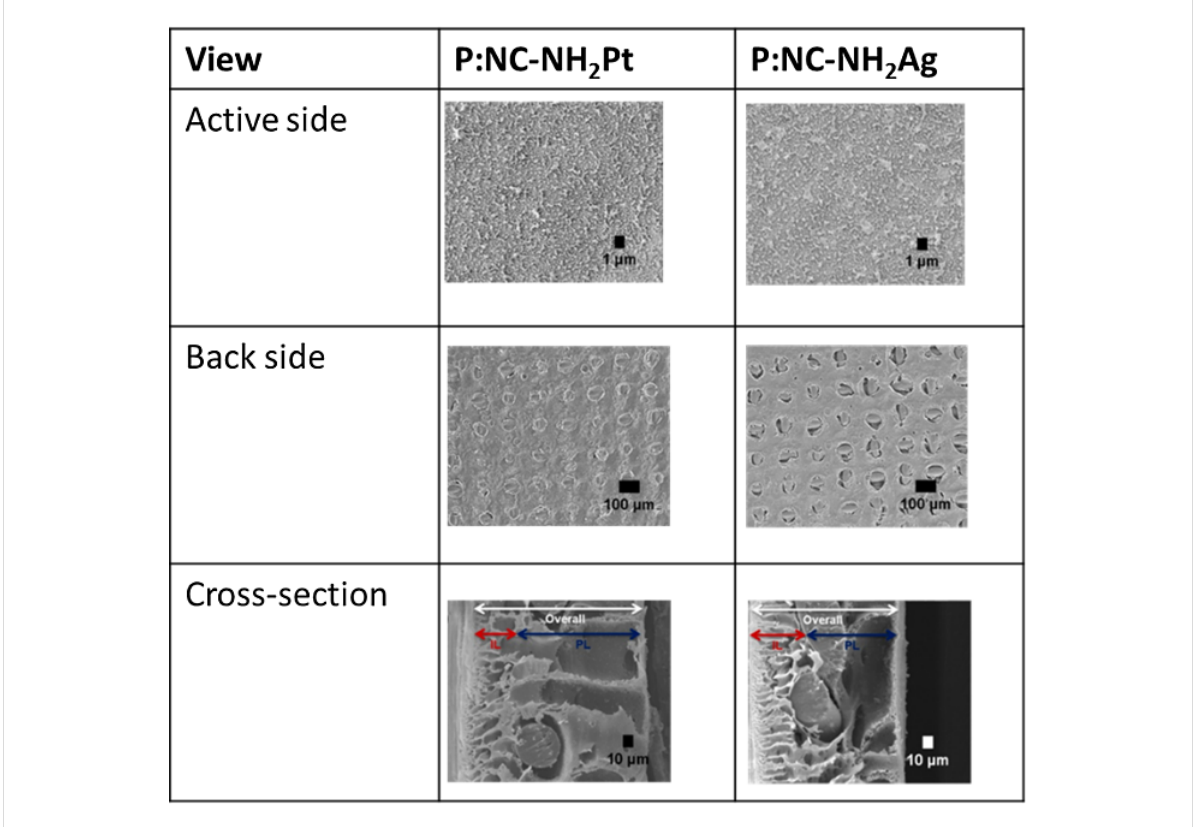
Figure 4: The morphology of MNC forward osmosis membranes with amino silane functionality as well as Pt and Ag nanoparticles. The ridge-and- valley morphology is commonly attributed to polyamide membranes. Reprinted (adapted) with permission from [146], copyright 2017 American Chem- ical